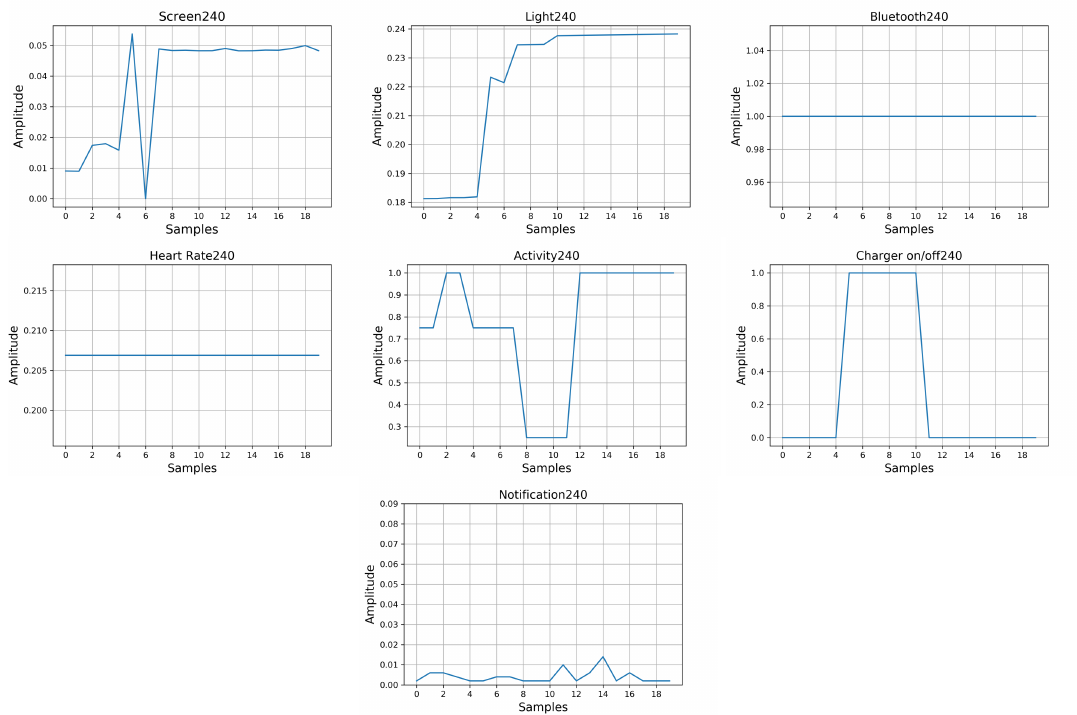
Figure A3. Inputs of input user 240 (screen, light, Bluetooth, heart rate, activity, notification and charger on/off